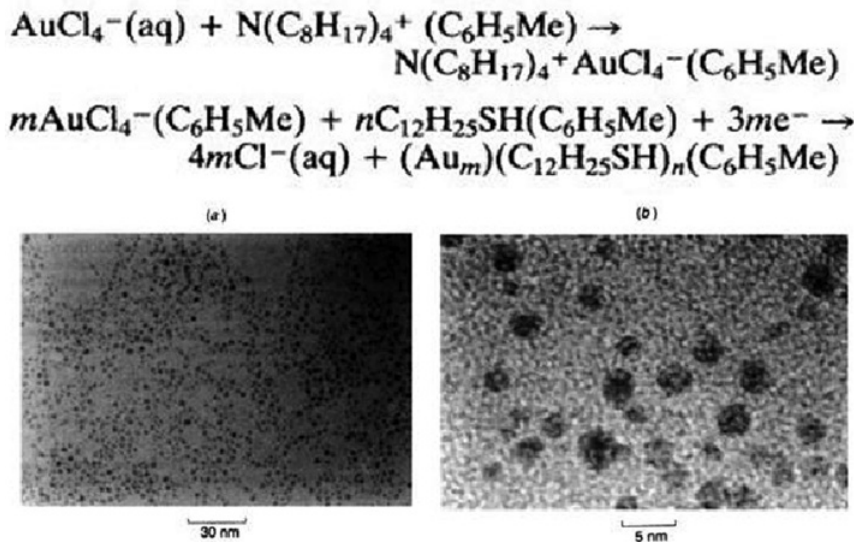
Figure 1: Brust method description (top). TEM pictures of the thiol derivatized gold nanoparticles at (A) low and (B) high magnification (down). Adapted from Ref. [53] with permission of The Royal Society of Chemistry.